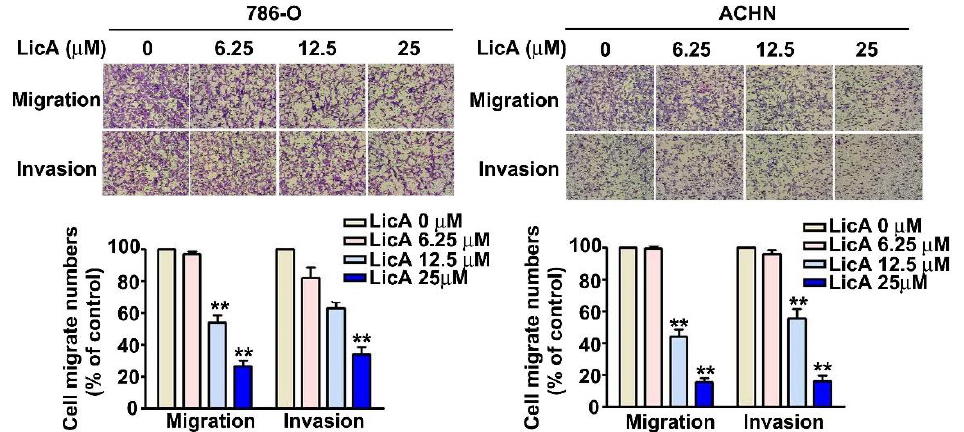
Figure 2. The effects of LicA on the invasion and migration of RCC cells. After being exposed to different concentrations of LicA (0, 6.25, 12.5, and 25 µM) for 24 h, 786-O and ACHN cells were tested for migration and invasion utilizing migration and invasion assays. Giemsa stain was used to stain cells on the lower surface of the Boyden chamber, and the cells were then photographed at 400× under a light microscope. The quantity of migrating or invaded cells is presented as a histogram chart in the lower panel. The results of at least three separate experiments are reported as means ± SD. ** p < 0.01, compared with that of the untreated control (0 µM).